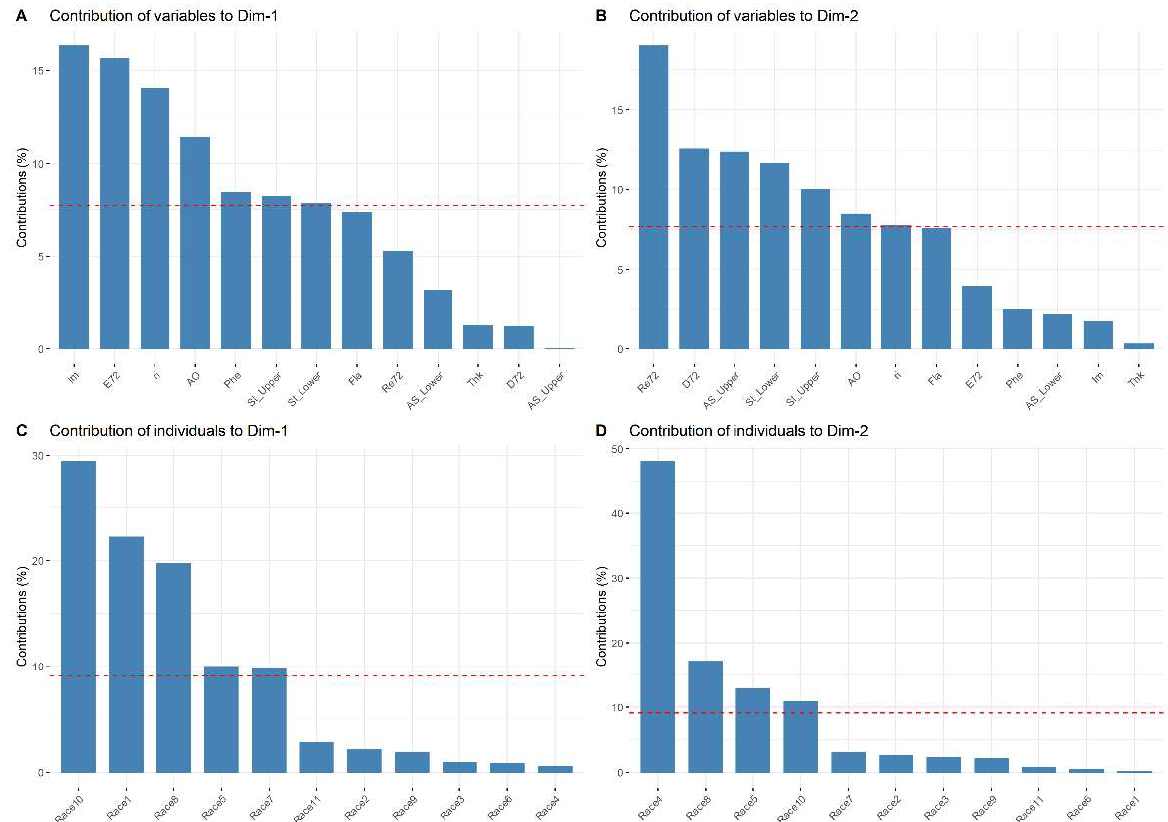
Figure 5. Contribution of the variables ( A , B ) and maize races ( C , D ) at 72 h. The dotted red line indicates the expected average contribution of the variable and maize race. Variables or maize races with a contribution larger than this cutoff is considered important in contributing to component.